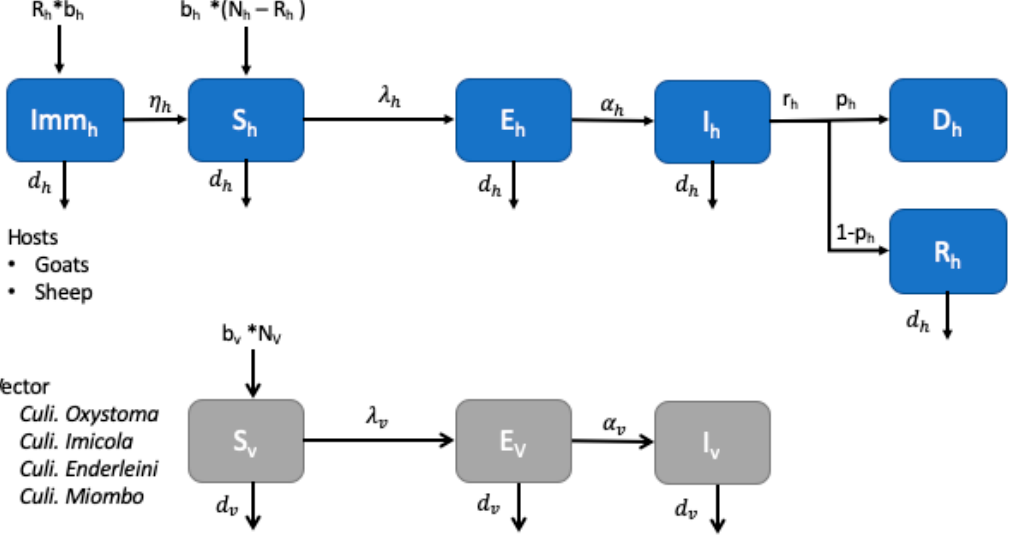
Figure 3. Pictorial representation of the mathematical model. Host dynamics are at the top of the figure, vector dynamics at the bottom.